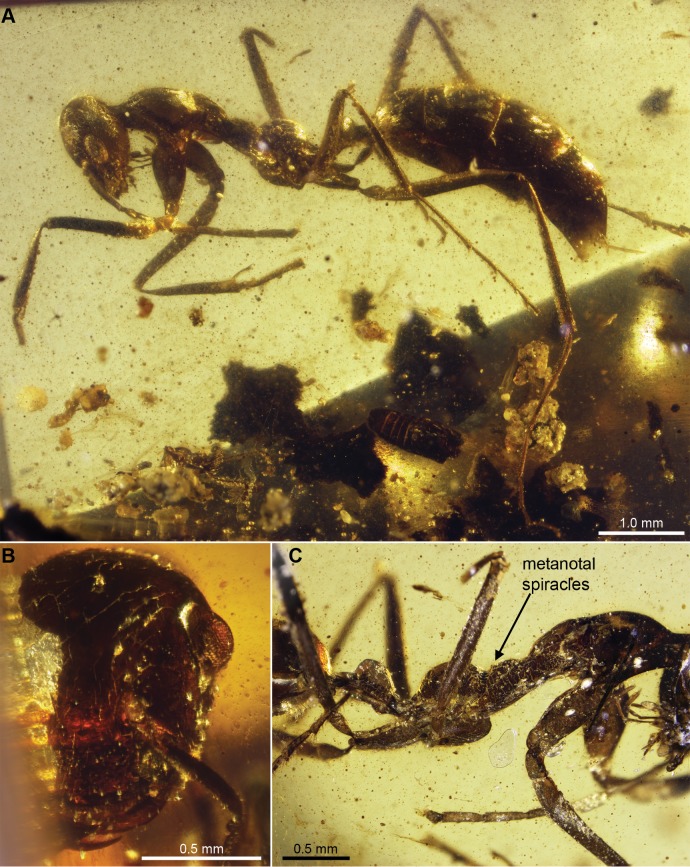

Sphecomyrmodes gracilis holotype JZC Bu324A photomicrographs.A. Lateral view of whole specimen. B. Frontal view of partially damaged head. C. Lateral view of elongate mesosoma, petiole, and first sclerite of gaster.